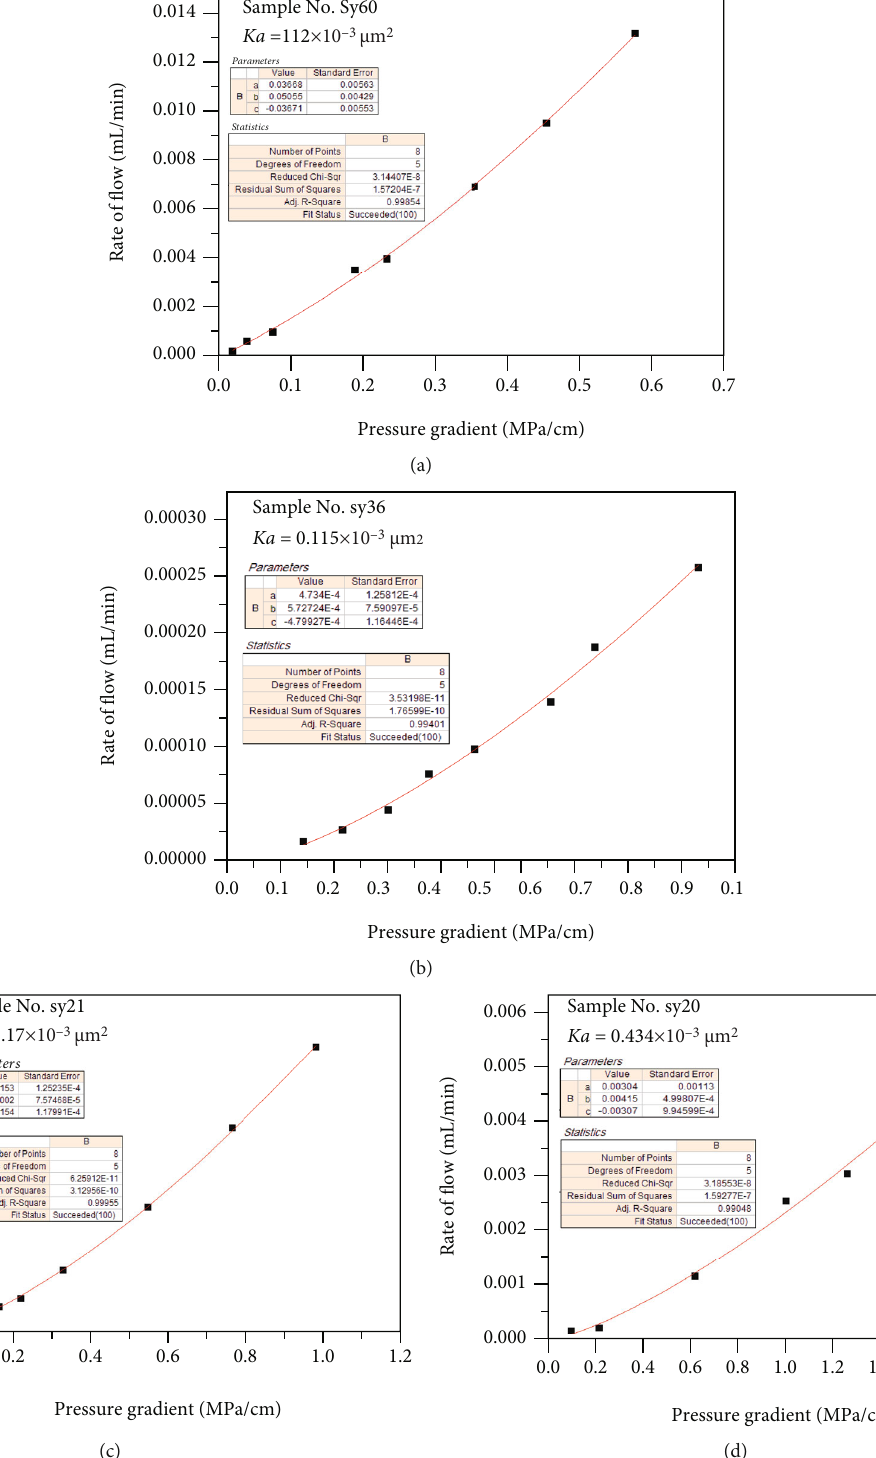
Figure 8: Flow curve of the oil phase in the core samples under the same stress. The relationship between the fl ow velocity and the pressure gradient is shown. Sy60 and Sy21 are the fractured cores, and Sy36 and Sy29 are the matrix